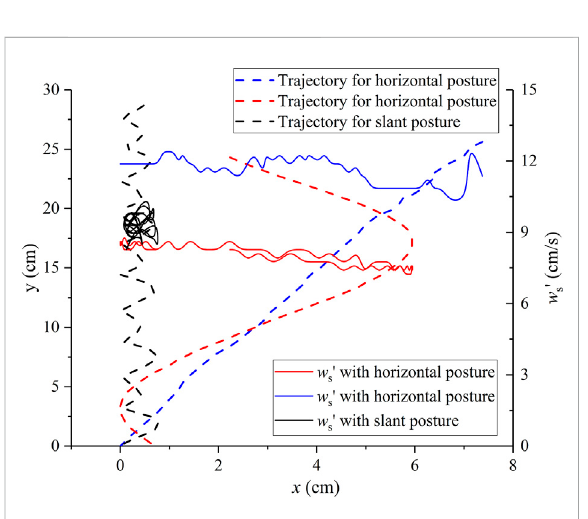
FIGURE 2 Trajectories and w s ’ of the Oncomelania with horizontal and slant postures.